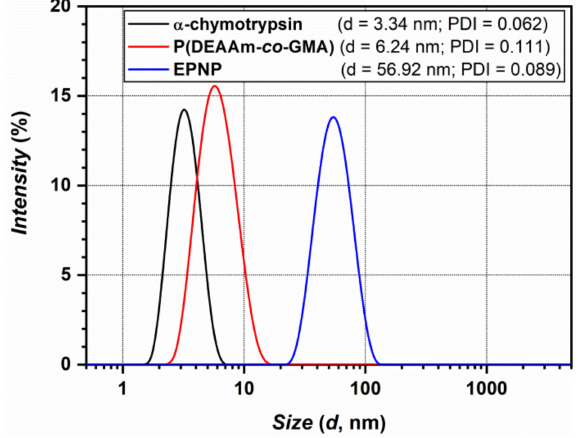
Figure 4. DLS size distribution curves of the α -chymotrypsin (black), the P(DEAAm- co -GMA) copolymer (Sample C) (red) and the produced enzyme–polymer conjugate